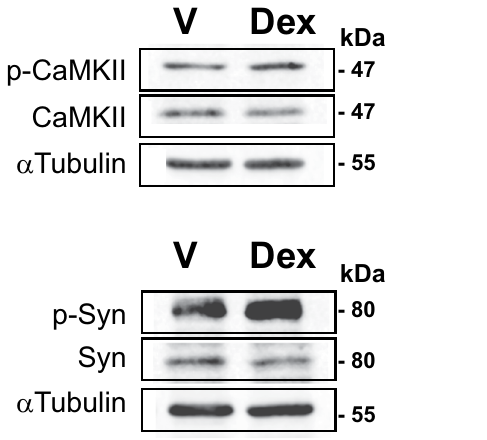
cytoplasm and nucleus, a significant proportion of GR is tethered or anchored to cell membranes of GC-sensitive cells. To test whether subcellular GR localization could be modified in the presence of ligand, L β T2 cells were incubated with 10 − 7 M Dex for 30 min before cell fractionation. As expected, nuclear GR was significantly increased upon Dex treatment, while cytoplasmic signal was concomitantly reduced (Fig. 3b), in agreement with the hormone-dependent GR translocation from cytoplasm to the nucleus. Importantly, the presence of ligand did not modify the intensity of MbGR signal suggesting that acute Dex exposure does not affect MbGR level (Fig. 3b). Since palmitoylation of ER was previously shown to be the major determinant for ER residence at the plasma membrane 34 , we evaluated the effect of the palmitoylation inhibitor 2-bromopalmitate (2-Br) on MbGR localiza- tion. As illustrated in Fig. 3c (upper panel), overnight incubation of L β T2 cells with 100 μ M 2-Br totally abolished MbGR localization without modifying the presence of the membrane marker, the κ -opioid receptor (KOR), in the membranous fraction (ratio Mb/Total = 1.32 ± 0.2 vs 1.43 ± 0.3), strongly suggesting that endogenous GR is palmitoylated. To further confirm GR palmitoylation, we performed an ABE assay 35 on L β T2 cells. During the ABE assay, unmodified free cysteines of immunoprecipitated GR were alkylated with NEM. Next, hydroxylamide (HAM) specifically cleaved palmitates from cysteines and then exposed these sites for biotinylation. Once the sites were labeled, palmitoylation was analyzed by SDS-PAGE and Western blotting using fluorophore-conjugated streptavidin (Strept); Strept signals correspond to protein biotinylation of palmitoylation sites. The same mem- brane was also used for Western blotting with an anti-GR antibody (Fig. 3c, lower panel). As shown in Fig. 3c (lower panel), Strept signals were only revealed after HAM treatment condition ( + ), despite an equivalent immu- noprecipitation efficiency between the two conditions. This result confirms that GR is clearly palmitoylated in L β T2 cells and demonstrates that GR is addressed to the plasma membrane through palmitoylation. Next, we assessed whether the palmitoylation site of GR was conserved with the one described for ER, AR and PR 28 . We mutated the ER corresponding cysteine residue of GR (Cys671) into Alanine (C/A) on a Flag-form of GR and performed an ABE assay after overexpressing GR Wt or GR C/A in HEK293 cells. A GFP-form of stathmin 1 (St1) known as a soluble non-palmitoylable protein 36 was used as a negative control. Strept signal was normalized to the amount of tagged protein detected on the same blot (Fig. 3d). As shown in Fig. 3d, GR Wt treated with HAM was significantly biotinylated and specifically labeled by Strept (about 2.7-fold induction compared to the absence of HAM), indicating that overexpressed GR is also palmitoylated in HEK293 cells. Importantly, mutation of Cys671 into Ala (GR C/A ) led to a GR mutant that remained palmitoylated at an equivalent level as the GR Wt (Strept/Flag signals between “ − HAM” and “ + HAM” increased by 3.6 ± 1.5 -fold vs 2.7 ± 1.2 -fold, respectively). Immunoprecipitated stathmin 1 (St1) was not labeled by Strept providing additional support for GR palmitoy- lation. Thus, in sharp contrast with ER, the putative palmitoylation consensus site Cys671 is not involved in the GR membrane targeting. We also tested whether palmitoylated GR was responsible for rapid GC-induced signaling. As shown in Fig. 3e, overnight pretreatment of L β T2 cells with 100 µ M 2-Br totally abolished both Cort- and Cort-BSA-induced CaMKII phosphorylation when compared to vehicle. Total CaMKII levels were not modified by 2-Br treatment (not shown). These data unambiguously demonstrate that the palmitoylated form of GR triggers GC rapid sign- aling on CaMKII phosphorylation.